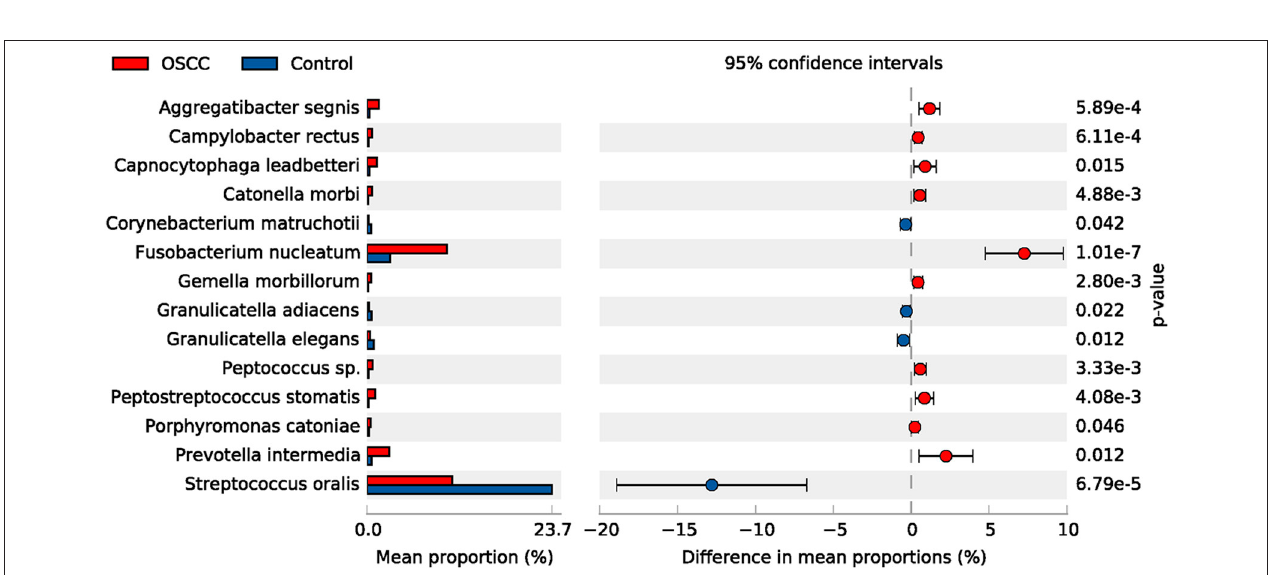
FIGURE 4 | Comparative taxonomic profile of the OSCC and Control groups at species level. The species with significant richness difference ( P < 0.05, computed by STAMP) between the two groups are shown.